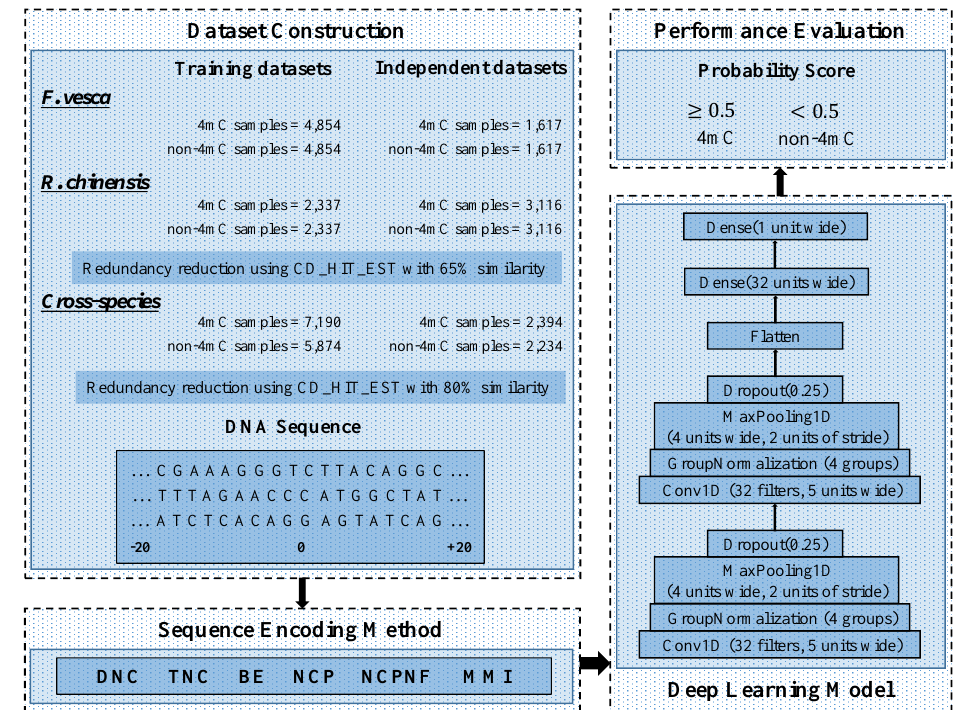
Figure 1. A complete structure of